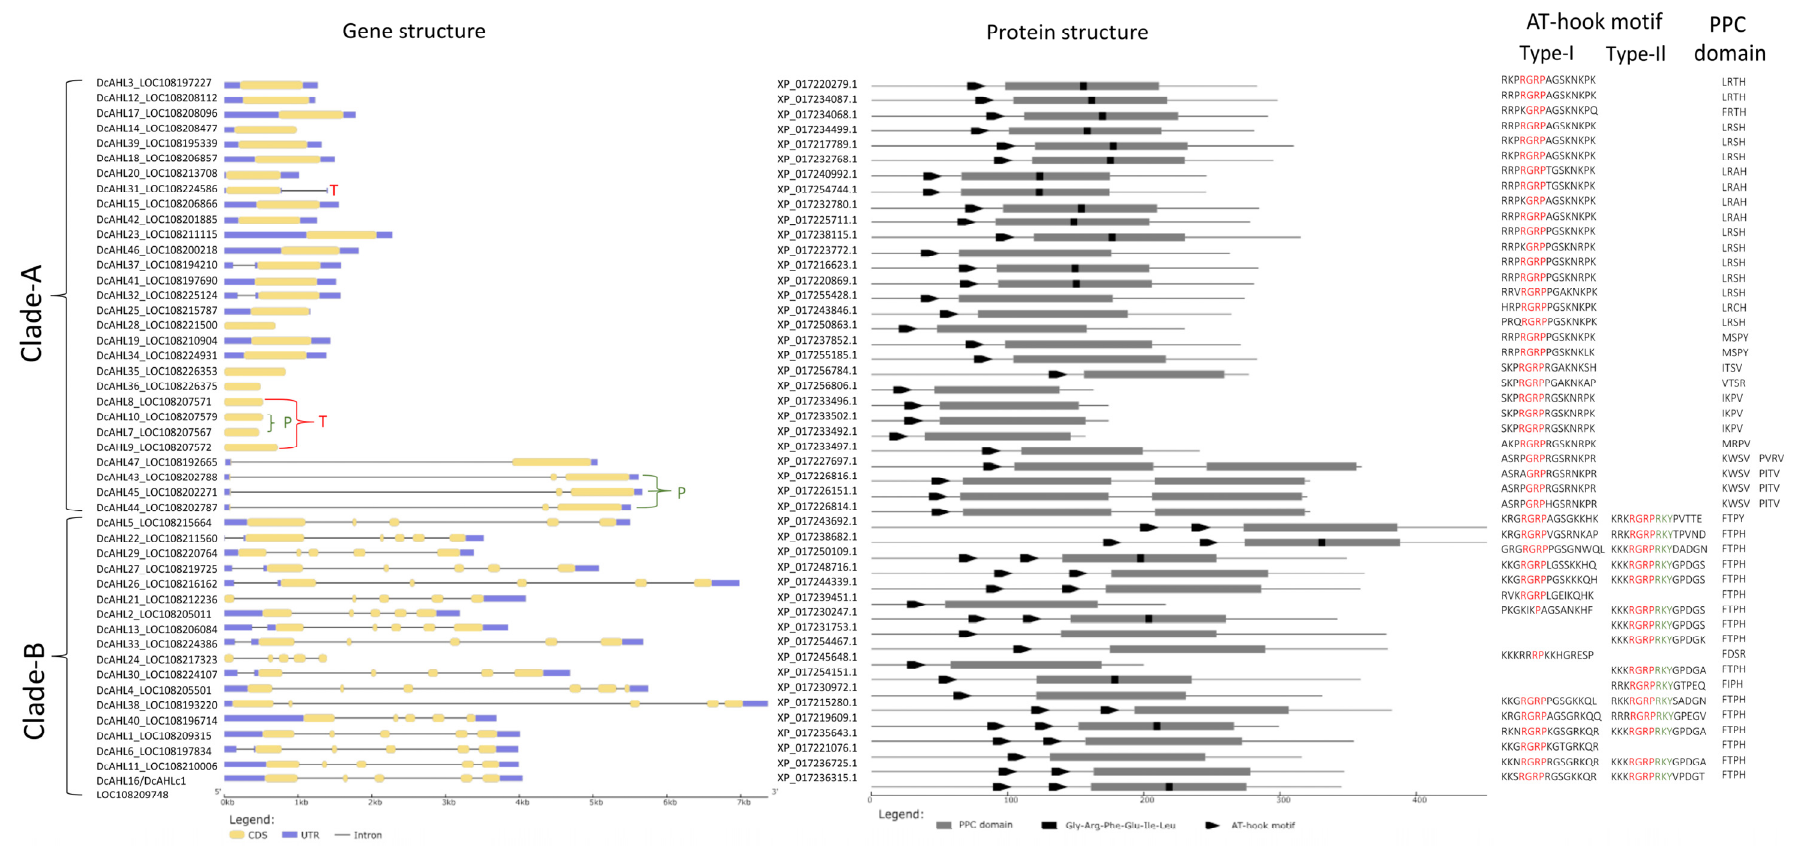
Figure 1. Structural characteristics of carrot AHL genes and proteins; left panel: exons are shown as yellow boxes, 5 ′ - and 3 ′ UTRs are shown as blue boxes, introns are shown as black lines, tandem and proximal duplication events are marked with T and P, respectively; right panel; PPC domain are shown as gray boxes, positions of the Gly-Arg-Phe-Glu-Ile-Leu core motifs within PPC domains are shown as black boxes, AT-hook motifs are shown as black arrowheads. Amino acid sequences of AT-hook motifs and the n -termini of the PPC domains are shown.